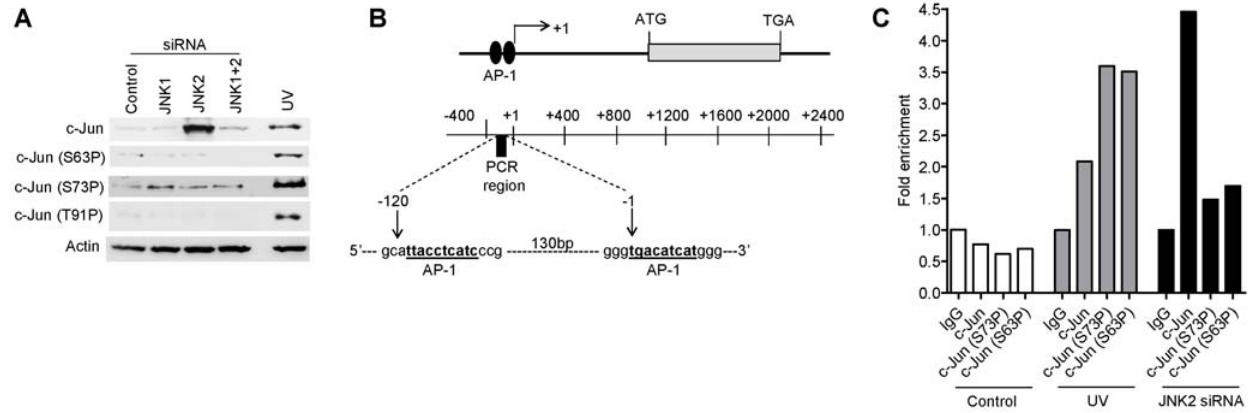
Figure 3. Hypo-phosphorylated c-Jun protein accumulates to high levels following JNK2 silencing, this effect is dependent upon JNK1 and correlates with c-Jun chromatin binding at the c-Jun promoter in HCT116 cells. (A) Total c-Jun protein and phosphorylations at S63, S73 and T91 following either UV-irradiation (right hand lane) or JNK1 and JNK2 RNAi-induced silencing. (B) Schematic showing c-Jun and the amplicon used for detecting c-Jun on the promoter. (C) Total and phosphorylated forms of c-Jun bound at the c-Jun promoter detected by chromatin immunoprecipitation (ChIP) with c-Jun and c-Jun phospho-specific antibodies. Histogram shows fold-enrichment relative to IgG controls (Methods).